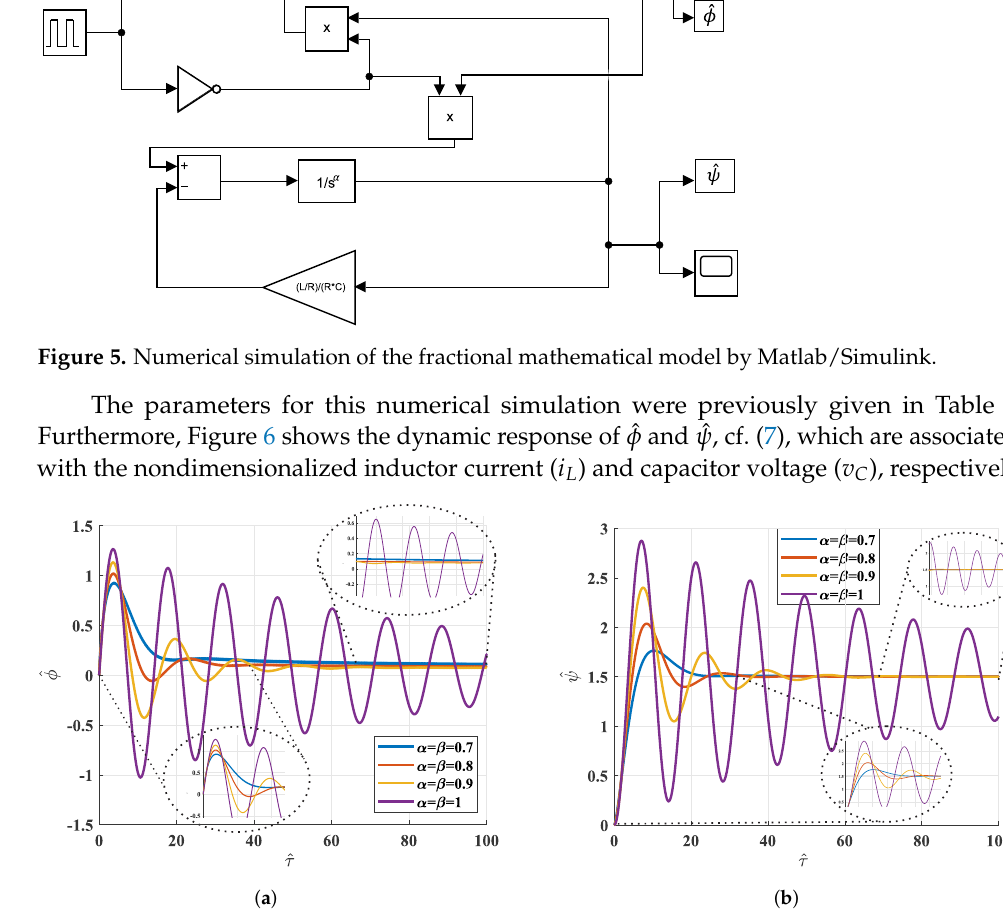
Figure 6. Nondimensionalized voltage and current of the fractional-order Buck-Boost converter. ( a ) Nondimensionalized inductor’s current. ( b ) Nondimensionalized capacitor’s